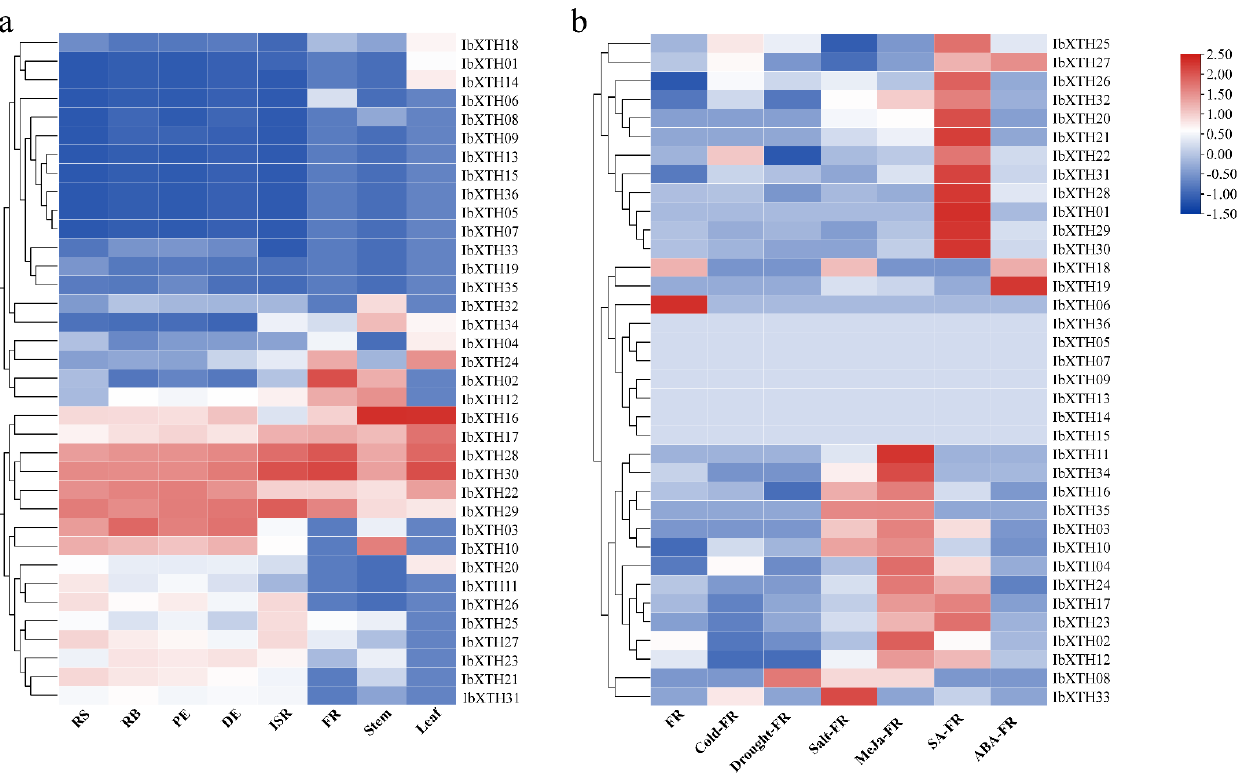
Figure 8. Expression pattern of XTH genes in different tissues and different treatments. ( a ) Expression pattern of the sweet potato XTH genes in different tissue with col scale. RS represents root stock, RB represents root body, PE represents proximal end, DE represents distal end, ISR represents initiated storage root, and FR represents fibrous root. ( b ) Expression pattern of the sweet potato XTHs in FR tissue under different abiotic stress and hormone treatment with row scale. Red represents high expression, and blue represents low expression. All ratios are log 2 transformed so that inductions and repressions of identical magnitude are numerically equal but opposite in sign.